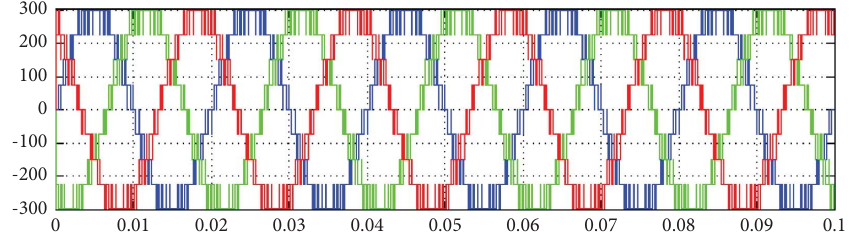
Figure 18: Phase voltages for three-phase 9-level inverter.